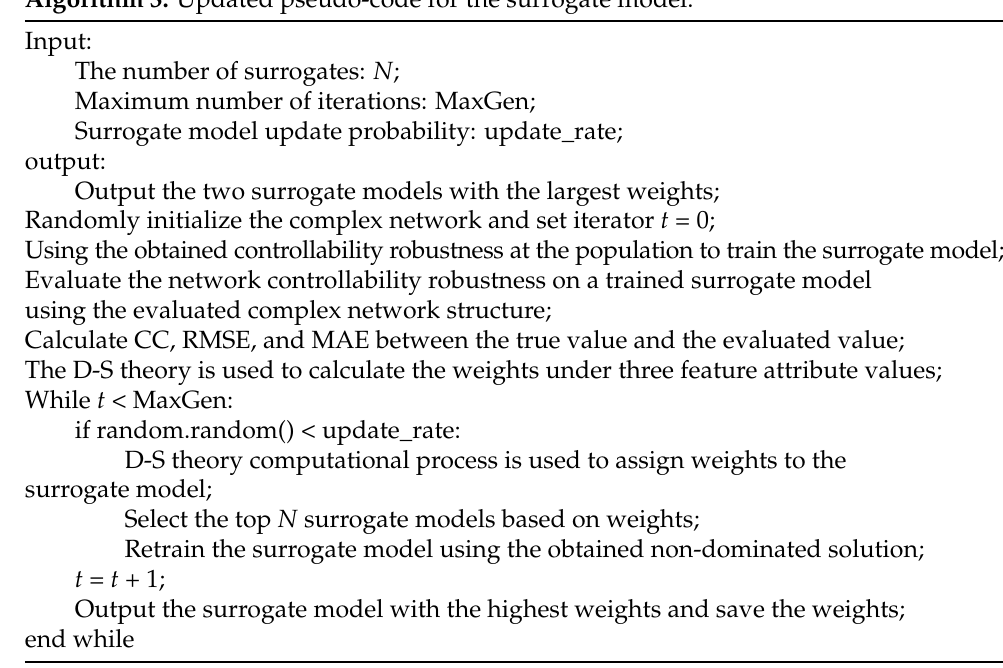
Algorithm 3: Updated pseudo-code for the surrogate